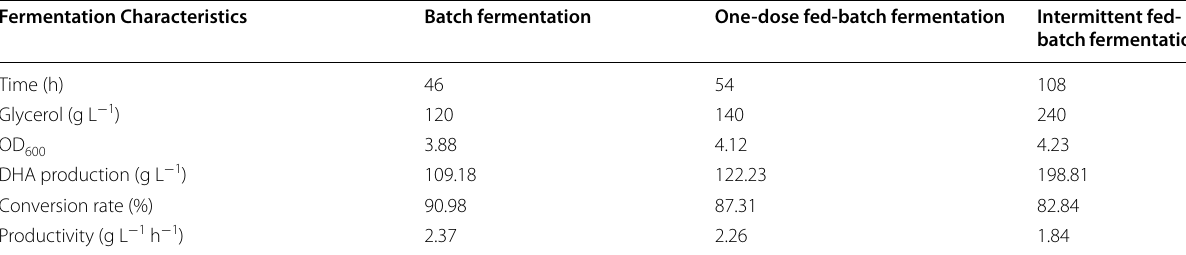
L − 1 initial glycerol ·